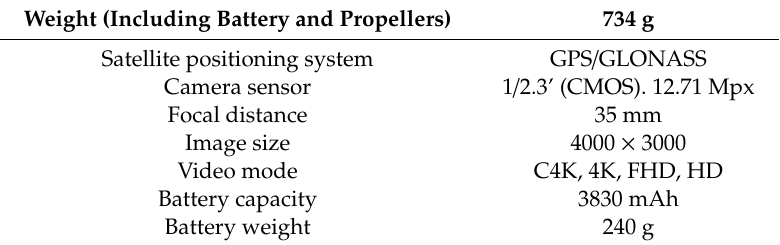
Figure 3. MAVIC pro platinum model UAV. Table 2. MAVIC pro platinum technical characteristics.